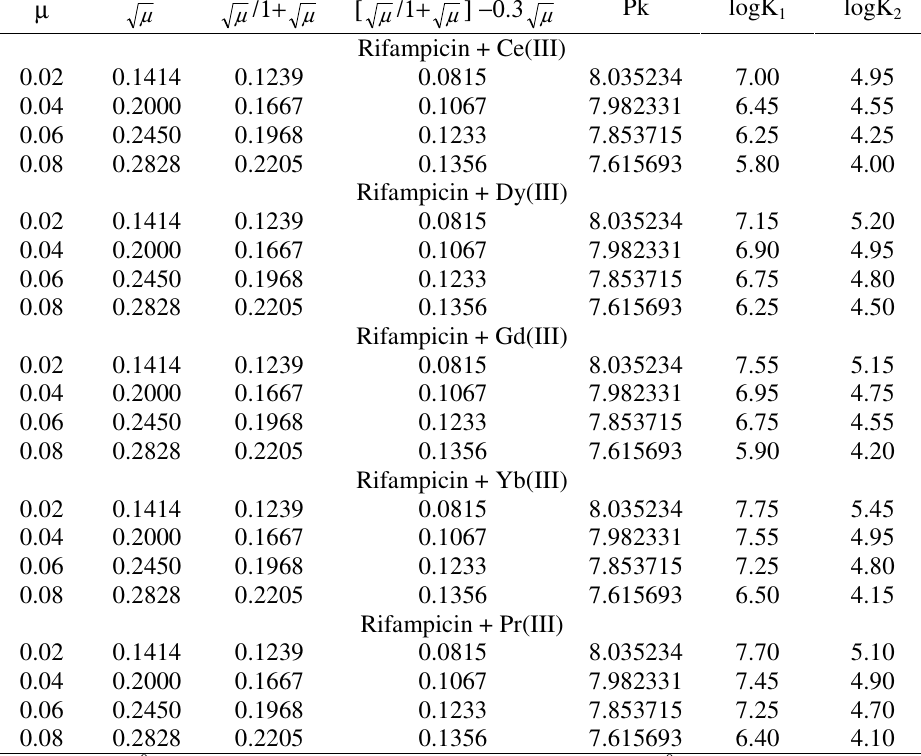
Table 1. Proton-ligand (pK) and metal-ligand stability constant (log K) values for Ce(III), Dy(III), Gd(III),Yb(III) and Pr(III) metal ions with rifampicin at various ionic strength ( µ )